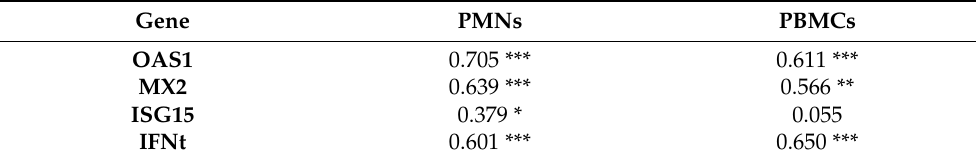
Table 2. Pearson coefficients evaluating the associations between plasma concentration of PAGs